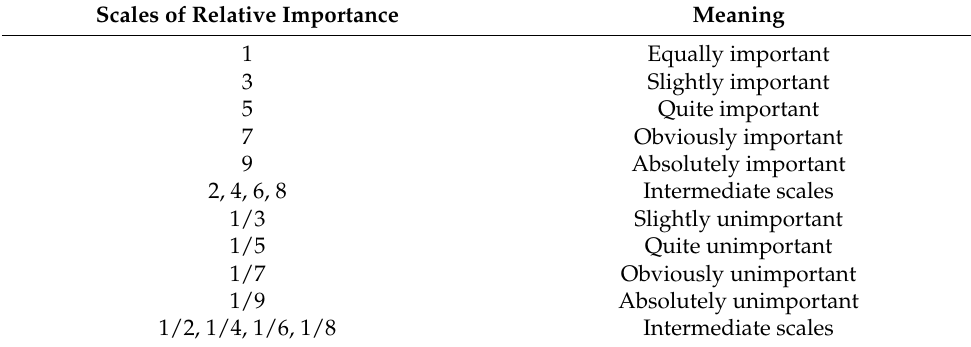
Table 2. Scales of relative